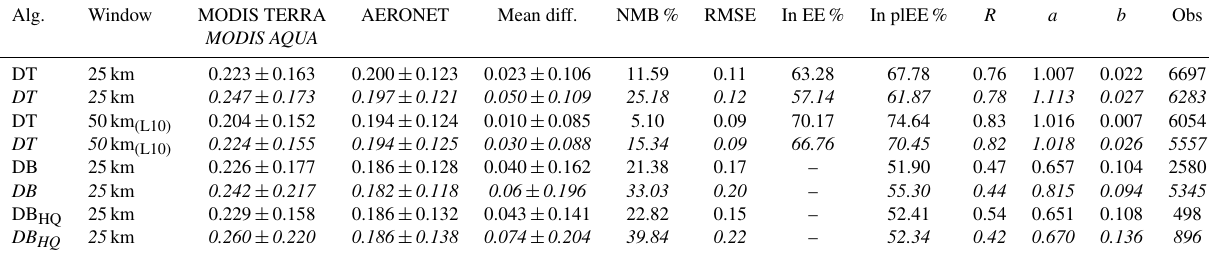
Table 2. Results of the comparison of spatially (using a spatial window around each station) and temporally ( ± 30min from the MODIS over- pass time) collocated MODIS Terra and Aqua (italics) Collection 051 level-2 and AERONET sun photometric (quadratically interpolated) AOD 550 observations for the Eastern Mediterranean stations. The algorithms used for the production of the validated MODIS data (DT and DB), the spatial window used for the spatial collocation (25 × 25km 2 or 50 × 50km 2 window around each station) with the AERONET data, the average MODIS and AERONET AOD 550 and the corresponding ± 1 σ values, the mean difference between them, the normalized mean bias (NMB) and the corresponding root mean square error (RMSE), the percentage of the collocation points that fall within the expected error (EE) envelope and the pre-launch expected error (plEE) envelope (expected uncertainty – EU envelope for DB data), the correlation coefficient R , the slope (a) and the intercept of the regression line (b) and the number of the collocation points are given in the table. L10 denotes the use of a collocation window of 50 ◦ × 50 ◦ as in Levy et al. (2010), while HQ denotes the use of high-quality data only.